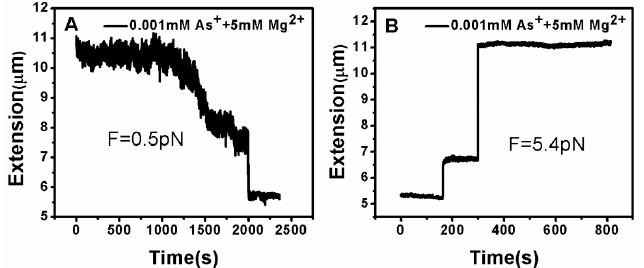
Polymers 2017 , 9 , 128 5 of 9 Figure 4. DNA structures in solution of ( A ) 0.01 mM spermine and ( B ) 0.5 mM As + . 3.2. Tethering of Single DNA Molecules DNA tethering was achieved in a magnetic tweezers (MT) setup, as described above. We first put the microsphere-bound DNA molecules in NaBr buffer (1 mM) and magnesium ion (5 mM) into the flow cell and incubated them for 30 min at room temperature. Then, we could find that some paramagnetic beads had tethered to the surface of the sidewall through a single DNA molecule. In the absence of any condensing agents, we found that the extension of DNA was close to 16 μ m under high extension (>10 pN). Then, about 400 μ L of different concentrations of Ph 4 AsCl solution were loaded into the flow cell and stretched the DNA by approaching the magnet to the bead, or releasing the bead by moving back the magnet while the extension of the DNA molecule was monitored in real-time. The results of the DNA tethering are shown in Figures 5 and 6. From Figure 5A, we can see the stepwise shrinking of the DNA extension when a constant 0.5 pN pulling force was exerted upon the bead at low concentration of Ph 4 AsCl (1 μ M). After the DNA molecule condensed to a compact state, we had to apply much larger force (5.4 pN in this case) to unravel the condensed structure, as shown in Figure 5B. We could repeat the shrinking and unraveling many times, and the processes was reversible in our experiment. When the concentration of Ph 4 AsCl in the buffer increased, the tethering force increased accordingly to unravel the condensed DNA structures. We could still see